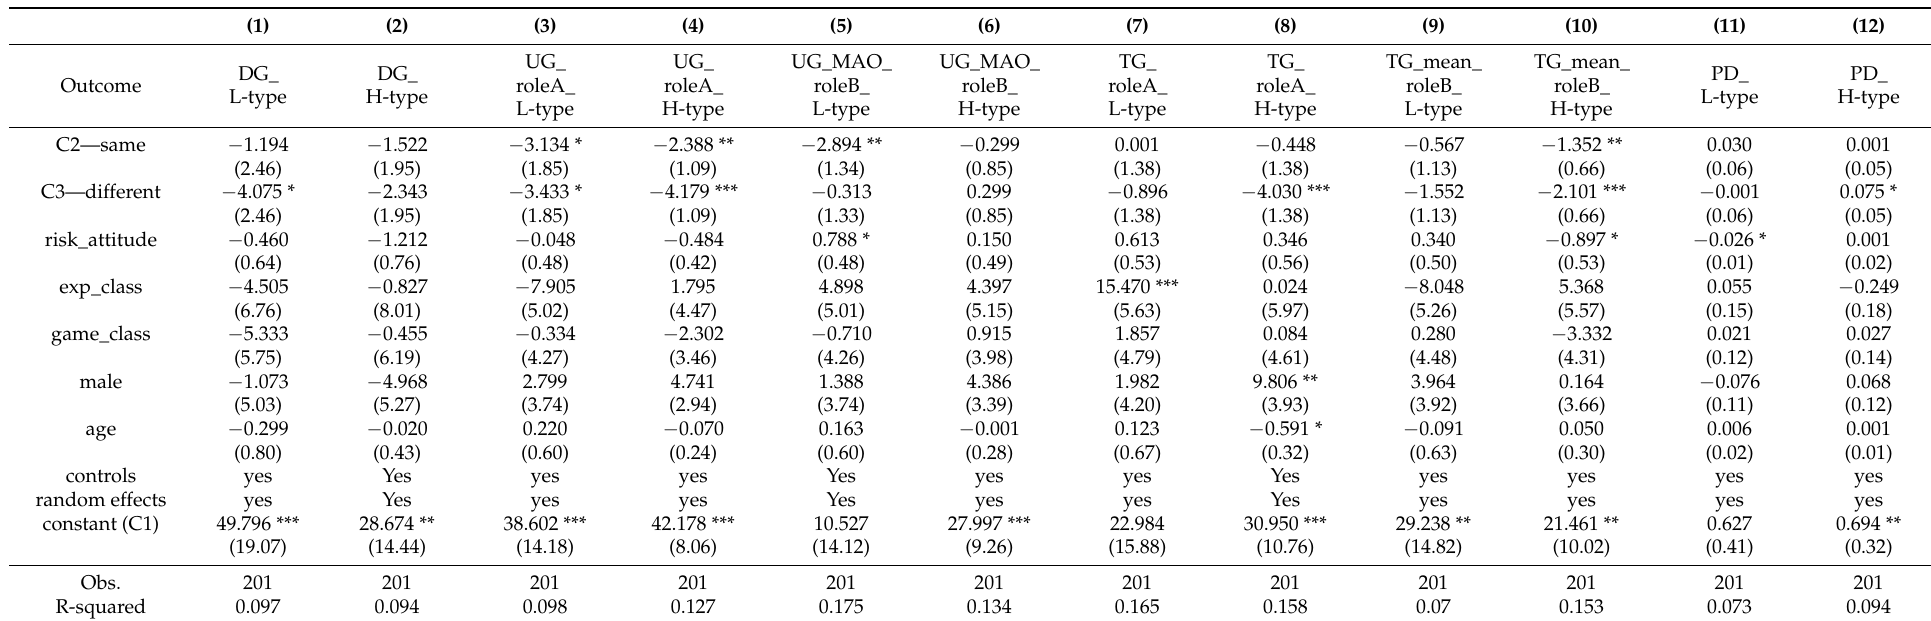
Table 6. Information effect (parametric